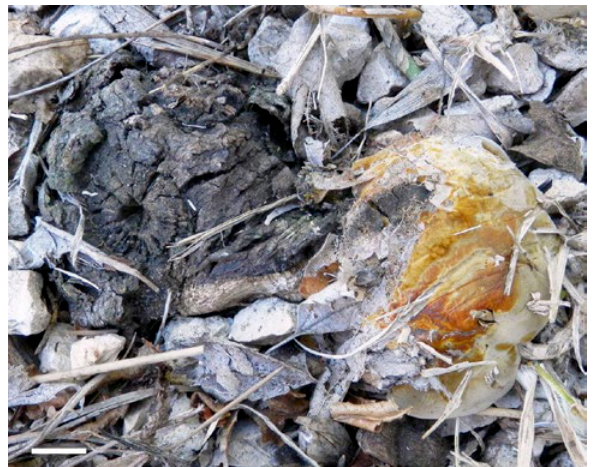
Figure 3. Fruitbody of Fomitiporia erecta on half-buried wood debris of a grapevine plant. Bar = 2 cm. Photograph: